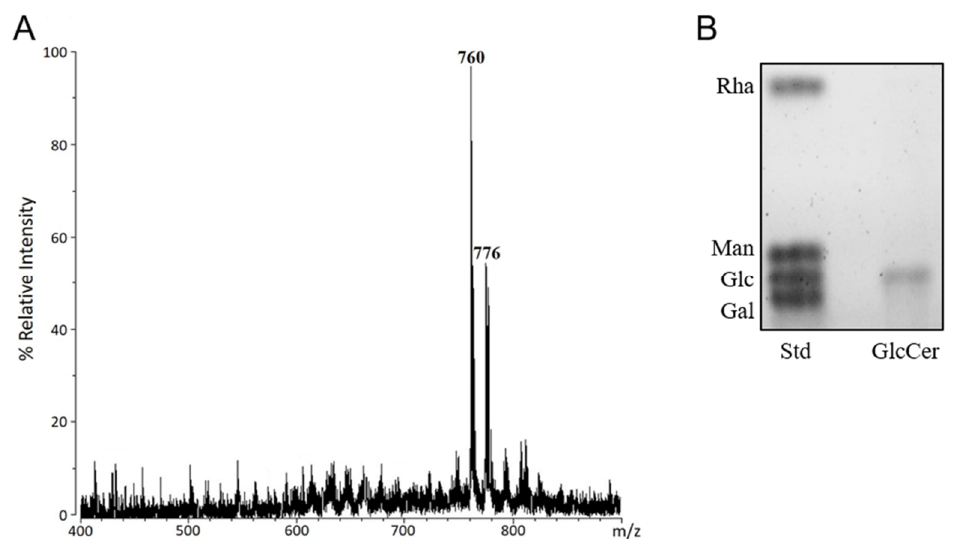
Figure 2. Positive ESI-MS (electrospray ionization mass spectrometer) (M+Li) analysis of GlcCer species from C. herbarum . ESI-MS1 of GlcCer species from C. herbarum ( A ). Thin layer chromatography (TLC) of hydrolyzed sugar from GlcCer species ( B ).